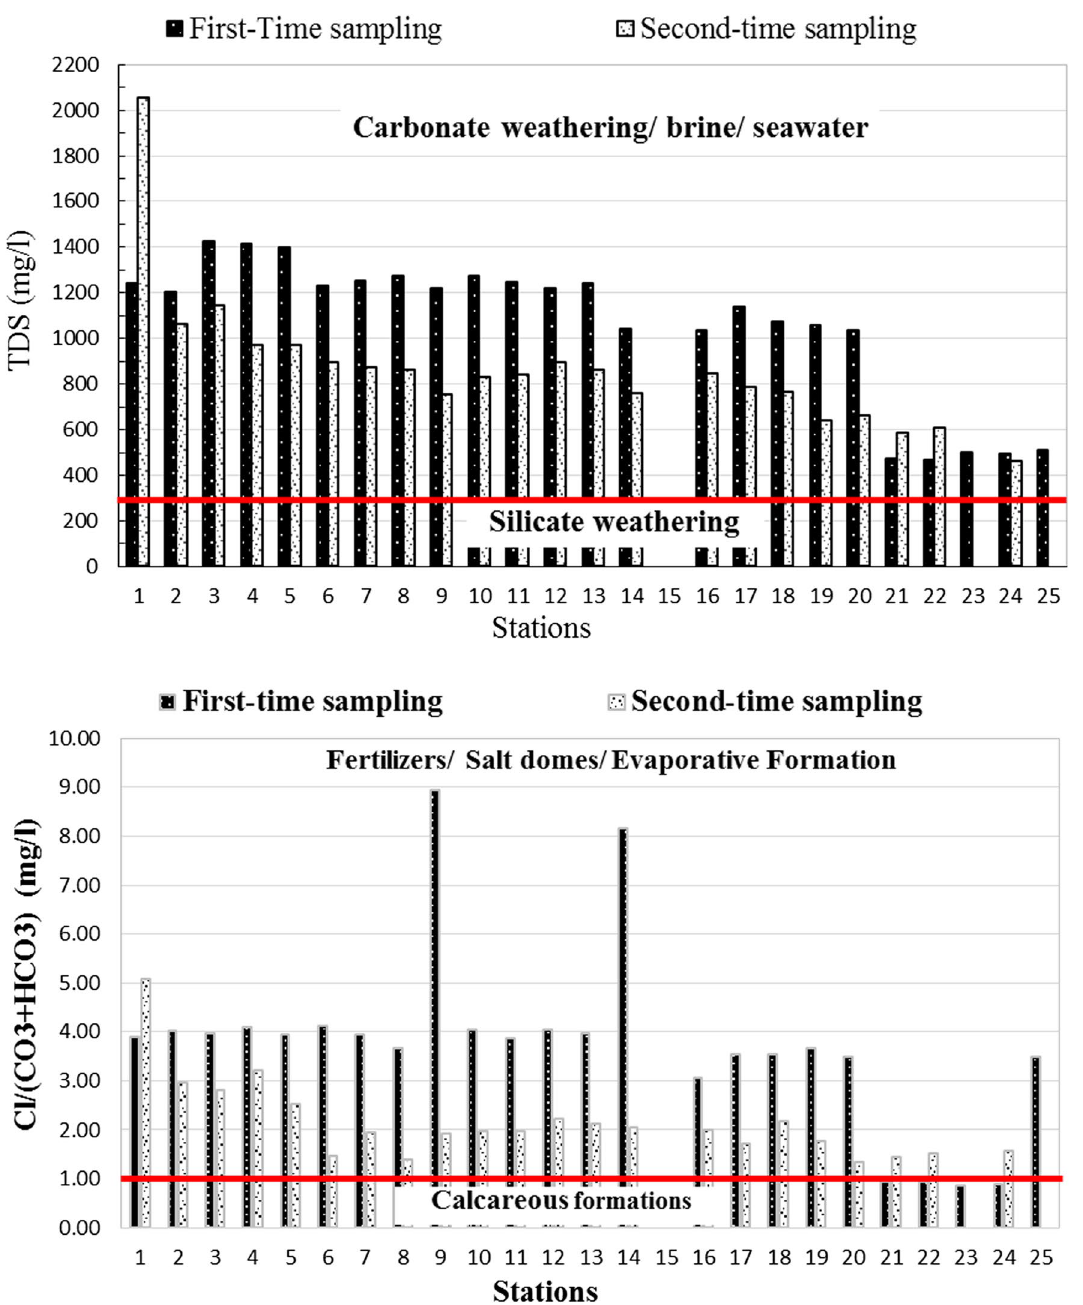
Fig. 10 Results of TDS and Cl/(HCO 3 + CO 3 ) ratio to evaluate the chemistry of the Karun River in the lake and downstream of the Gotvand-e- Olya